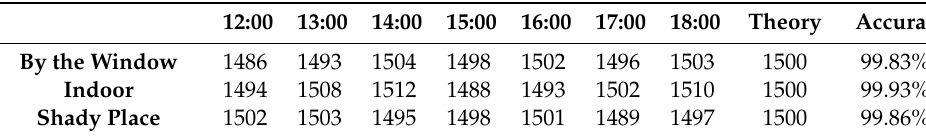
Table 1. Test data record.